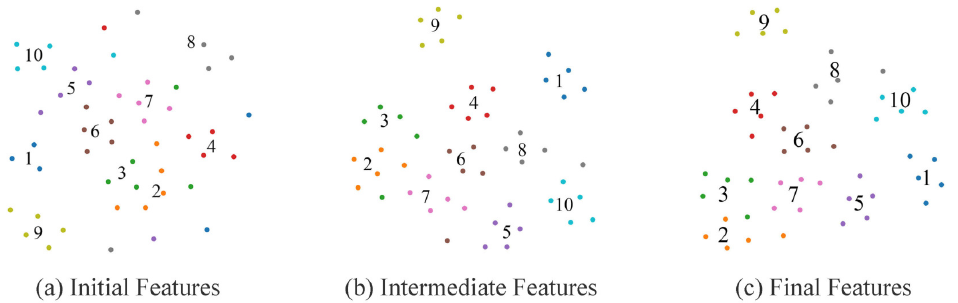
Figure 4. t-SNE visualization of support sample features in the FewRel 10-way 5-shot task. Different colors represent different categories. For visual representation, we annotated 10 different categories with numbers 1–10. ( a ) initial feature vectors extracted by BERT; ( b ) feature vectors after being transformed by the first layer of the HFGNN; ( c ) feature vectors obtained from the last layer of the